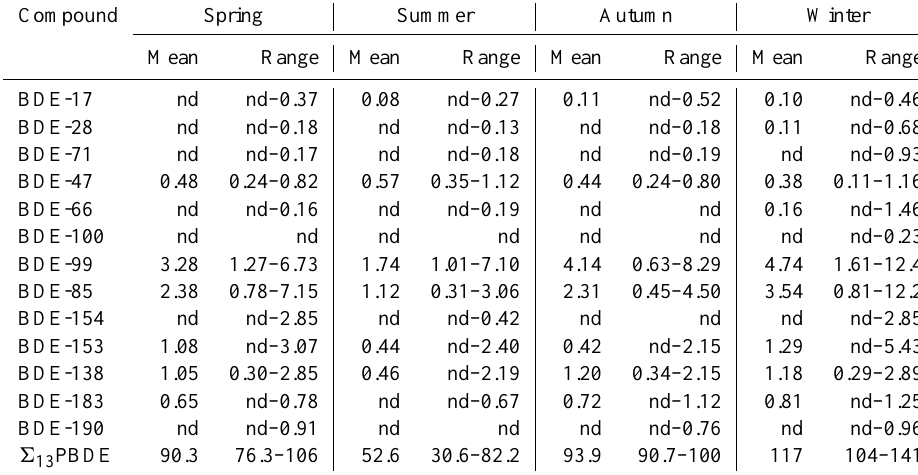
Table 3. Seasonal concentrations of size-resolved particulate PBDEs in the urban site of Shanghai (pg m − 3 ) .